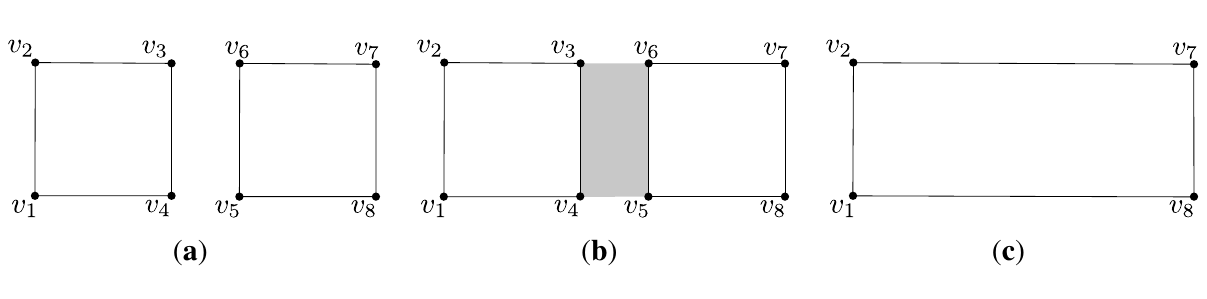
Figure 3. The two polygons in ( a ) are merged using the connected in ( b ) to give the result in ( c